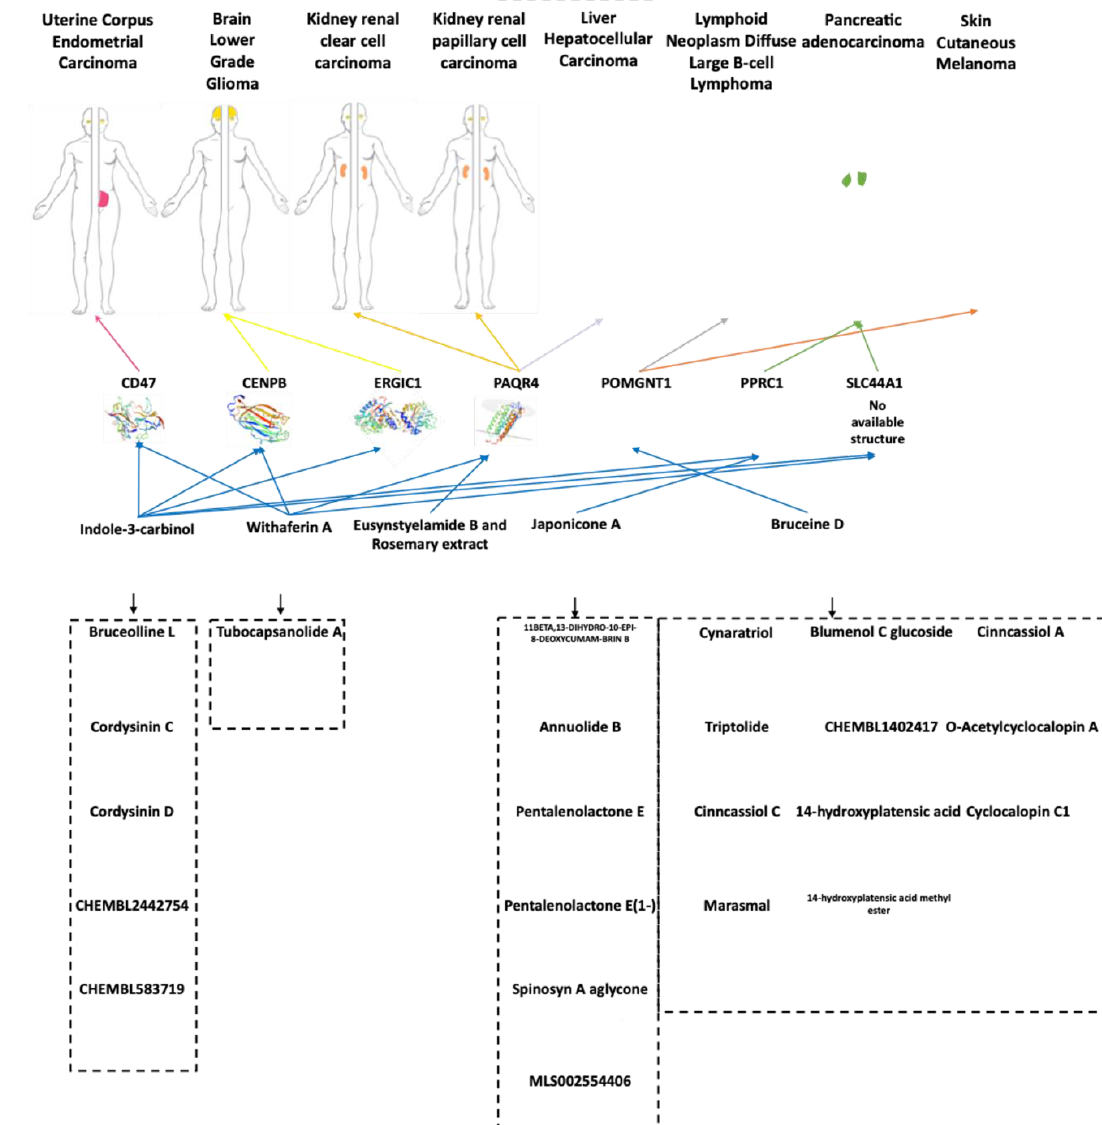
Figure 3. Natural compounds proposed for treatments in specific cancers. The 5 reference compounds (Bruceine D, Eusynstyelamide B, Japonicone A, Withaferin A and Indole-3-carbinol) associated to the specific cancer types where they can have potential efficacy, and the corresponding similar ones (enclosed in dashed rectangles) detected by SwissSimilarity and SwissADME (23 in total) are shown. Five compounds are similar to Indole-3-Carbinol, which triggers the down-regulation of 5 different genes. In particular, the down-regulation of CD47 enhances the survival in uterine corpus endometrial carcinoma; the down-regulation of CENPB and ERGIC1 enhances the survival in brain lower-grade glioma; the down-regulation of PPRC1 and SLC44A1 enhances the survival in pancreatic adenocarcinoma. Eleven compounds are similar to Bruceine D, that triggers the down-regulation of POMGNT1 that enhances the survival in lymphoid neoplasm diffuse large B-cell lymphoma and skin cutaneous melanoma. One compound, that is similar to Withaferin A, triggers the down-regulation of 4 different genes. In particular, the down-regulation of CD47 enhances the survival in uterine corpus endometrial carcinoma, the down-regulation of CENPB enhances the survival in brain lower-grade glioma; the down-regulation of PAQR4 enhances the survival in kidney renal clear cell carcinoma, in kidney renal papillary cell carcinoma and in liver hepatocellular